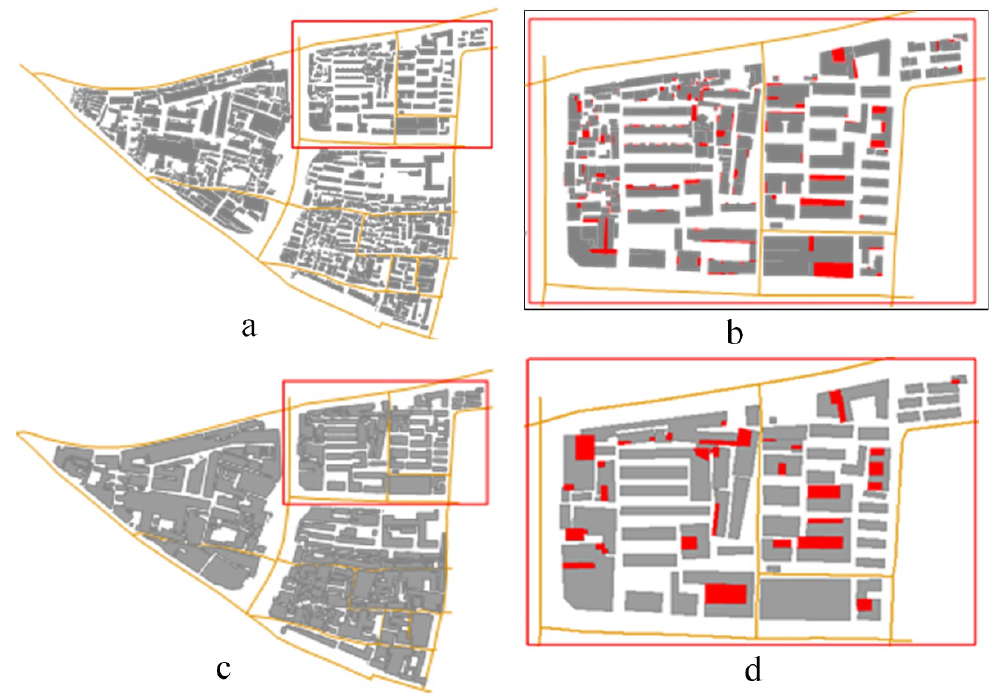
Figure 9. Building polygon experimental data and detected graphical units. ( a ) 1:2K building polygon data. ( b ) Graphical units within the red box in Figure 9a. ( c ) 1:5K scale building polygon data. ( d ) Close-up of graphical units within the red box in Figure 9c.